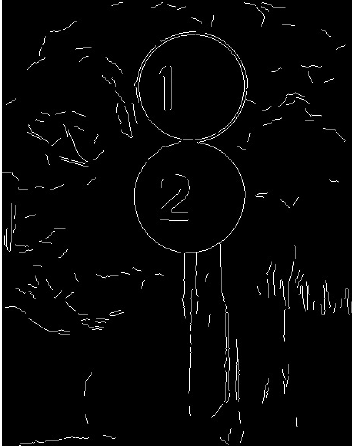
Figure 5: Traffic Sign Processed by EDLine